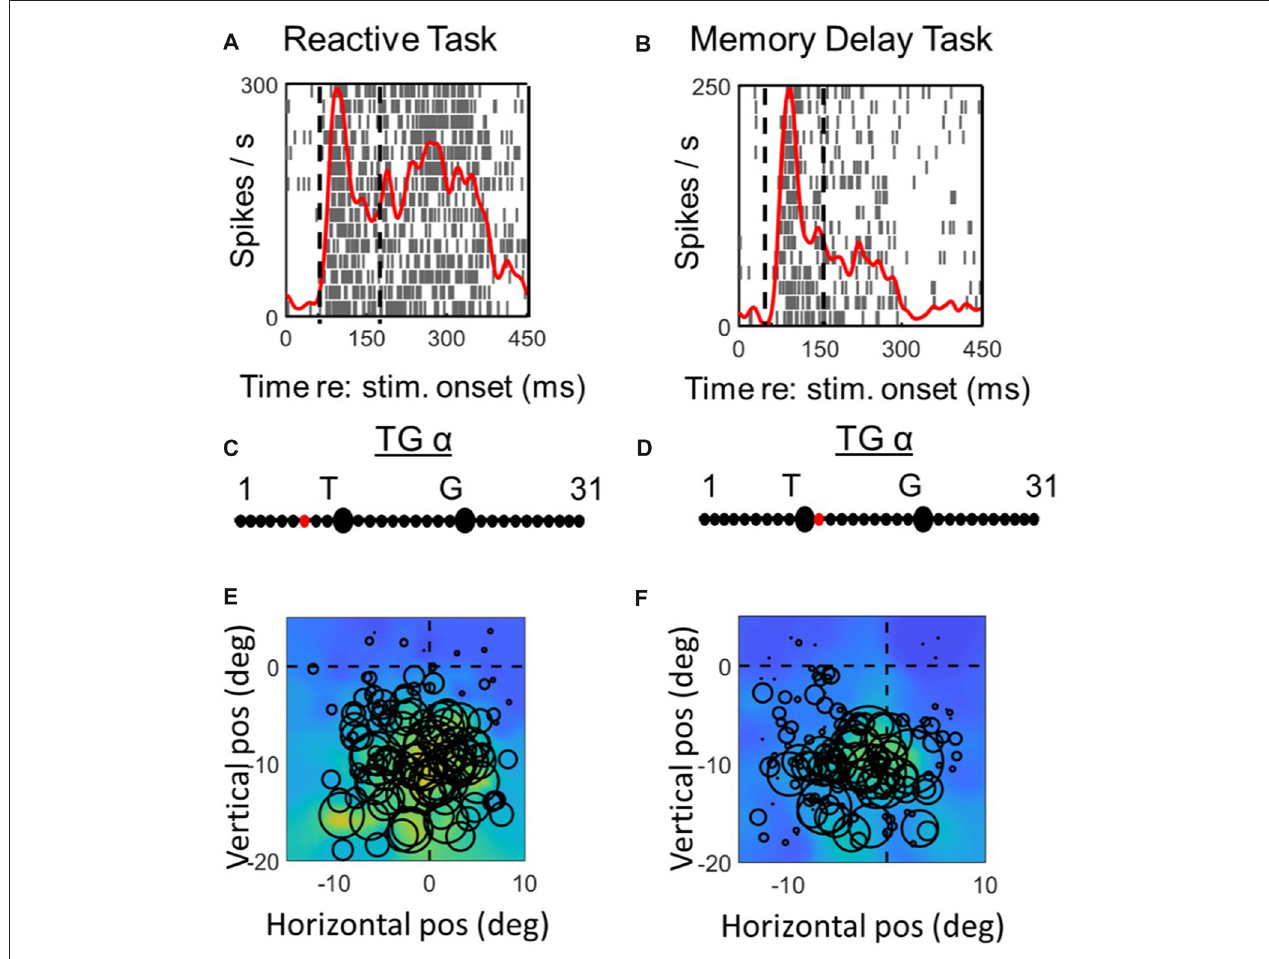
FIGURE 4 | Spatial analysis of visual activity during reactive task (left column) vs. memory delay task for one example VM neuron. The plotting conventions are the same as in Figure 3